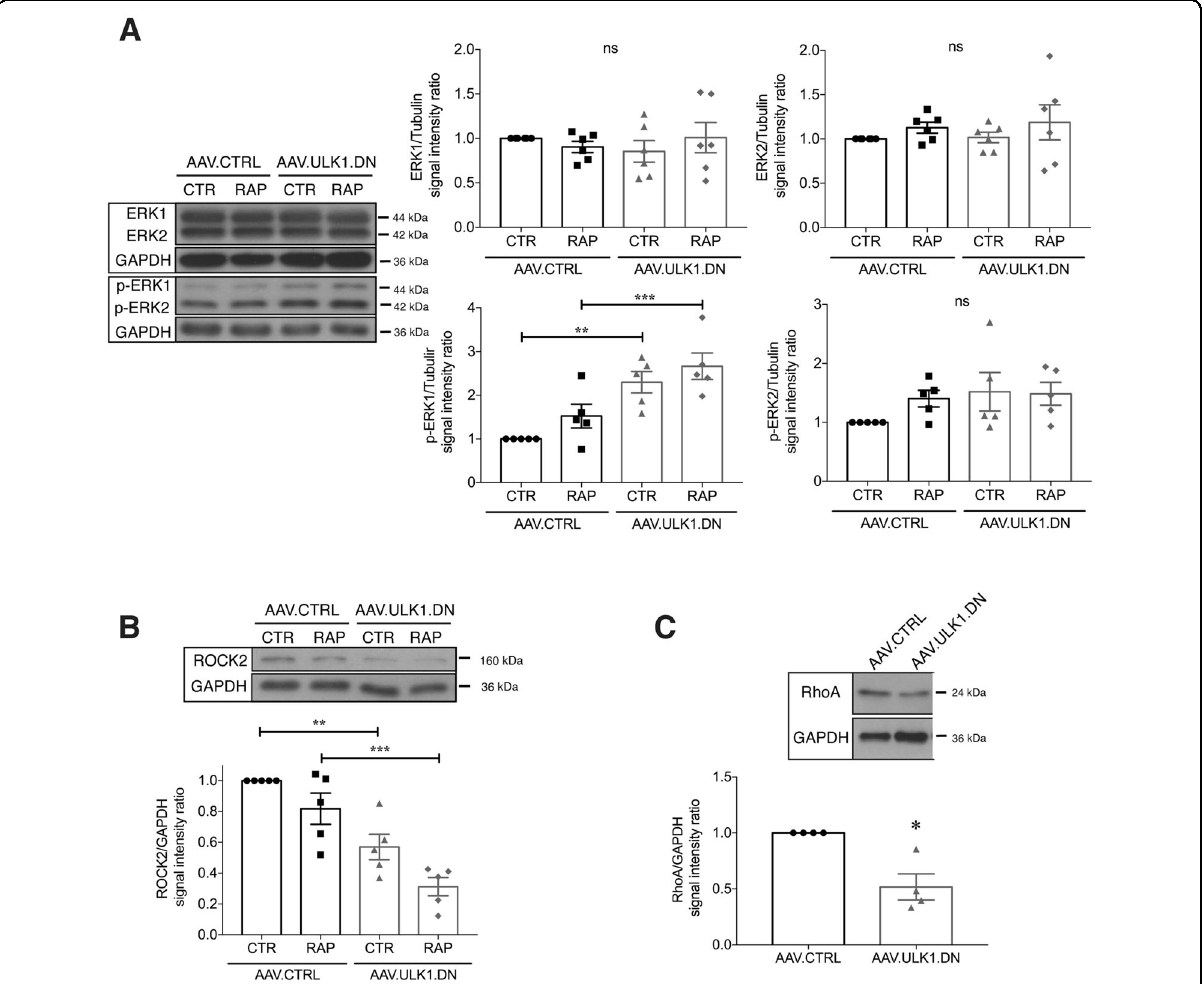
Fig. 7 AAV.ULK1.DN alters ERK, ROCK2, and RhoA signaling. Lysates were obtained from E18 rat cortical neurons on DIV 8 after transduction with AAV.ULK1.DN or AAV.mCherry. A – C Representative immunoblots of ERK1/2 ( A ), p-ERK1/2 ( A ), ROCK2 ( B ), RhoA ( C ) and the corresponding bands of the loading control GAPDH are shown. Quanti fi cations of the band intensities of ERK1/2 ( A - n = 6 independent cultures ) , p-ERK1/2 ( A - n = 5 independent cultures), ROCK2 ( B - n = 5 independent cultures), and RhoA ( C - n = 4 independent cultures) normalized to GAPDH as loading control. CTR: control. RAP: addition of rapamycin (750 nM) 24h before lysis. Data are presented as single data points and means± SEM. * P < 0.05, ** P < 0.01, *** P < 0.001, ns: no signi fi cant difference, according to one-way ANOVA and Tukey ’ s multiple comparisons test ( A , B ) or one-sample t -test ( C